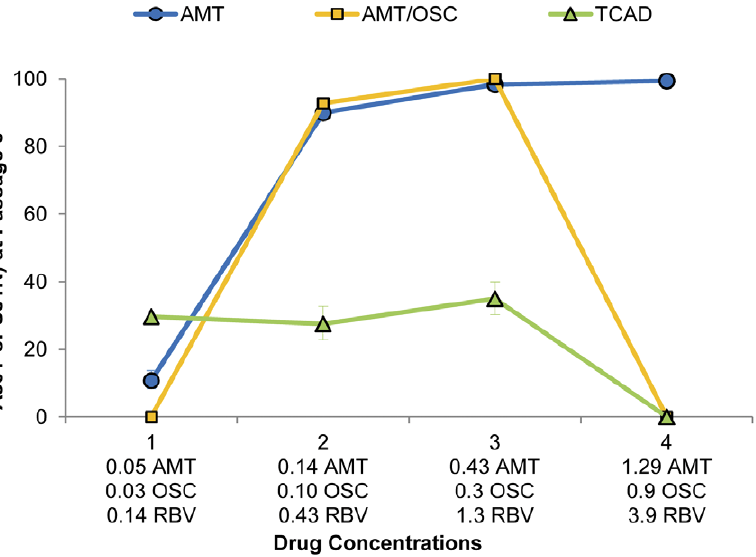
Figure 1. Percent of Resistant Virus Variants Generated at Passage 5 as a Function of Drug Concentration. Wild type influenza A/ Hawaii/31/2007 (H1N1) virus was passaged five times in MDCK cells, with the concentrations of drugs in each regimen kept fixed in between passages. The drug concentrations used are given in Table 2 and are discussed in the Materials and Methods. Concentrations 1 to 4 correspond to 1/ 9, 1/3, 1, and 3 times the clinically relevant concentration for each drug, respectively. The percent of virus variants bearing resistance-associated substitutions in M2 channel (V27A, A30T, or S31N) are presented as the mean of triplicate qASPCR reactions with 95% confidence intervals from a single well of MDCK cells. Concentration 3 represents the clinically relevant concentrations of all three drugs (AMT, OSC, and RBV, see Materials and Methods). doi:10.1371/journal.pone.0029778.g001 PLoS ONE |